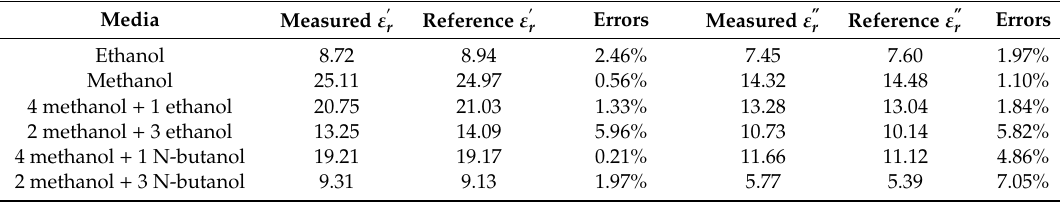
Table 4. Measurement results at room temperature. (“4 methanol + 1 ethanol” means the volume rate